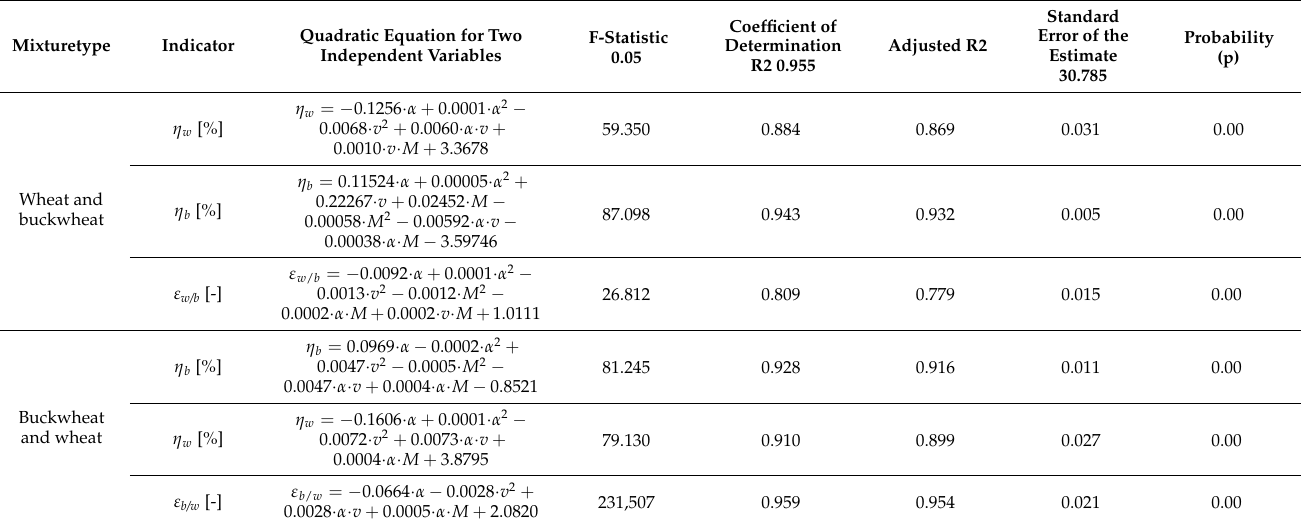
Table 2. Regression equations describing the separation efficiency of mixture components (the main crop seeds and seeds imitating impurities ( η ) and the separation efficiency index ( ε